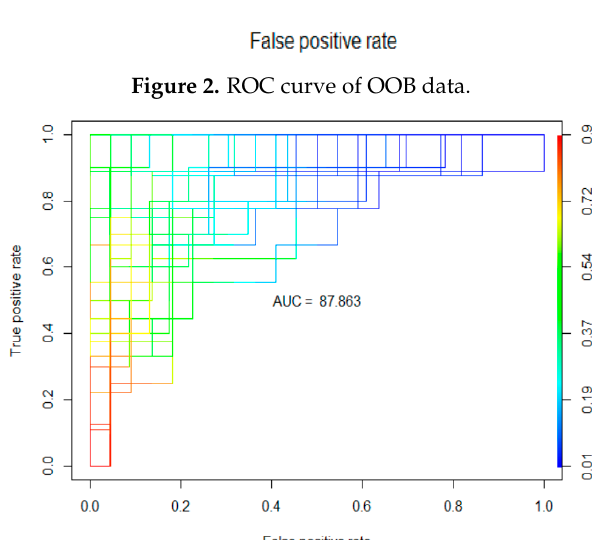
Figure 3. ROC curve of cross-validation.